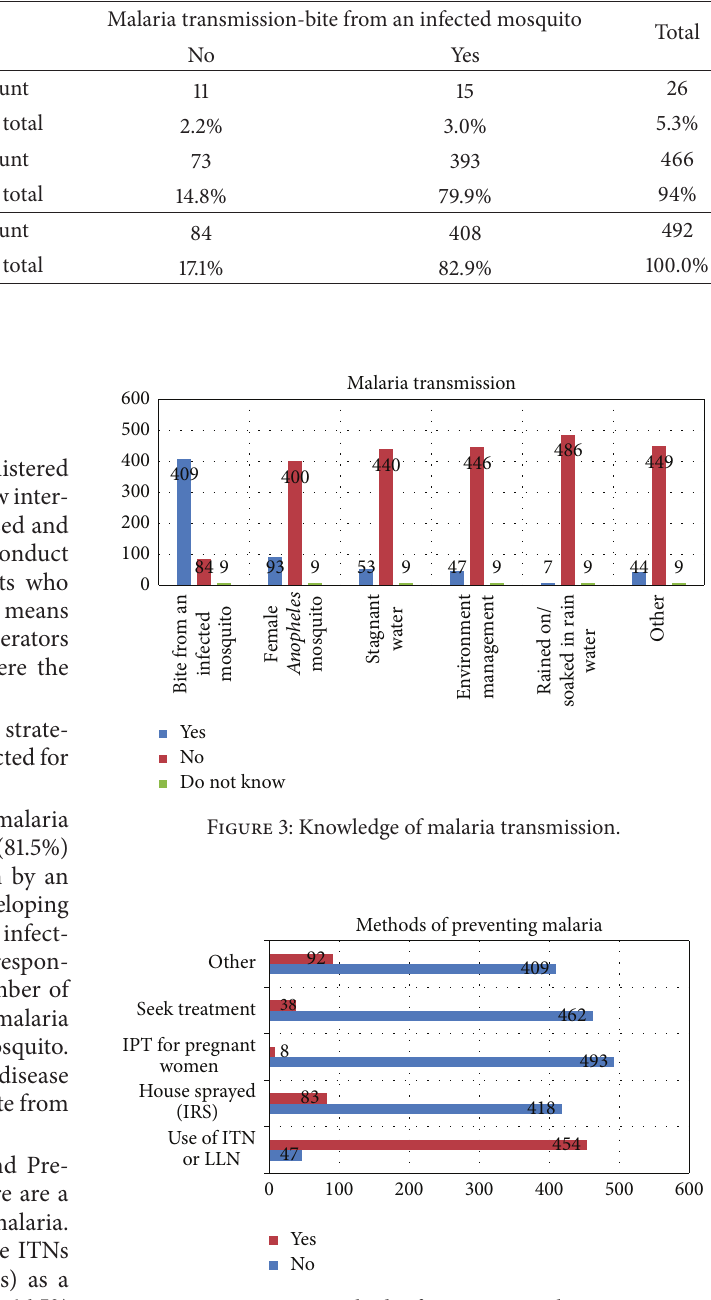
Malaria transmission-bite from an infected mosquito No